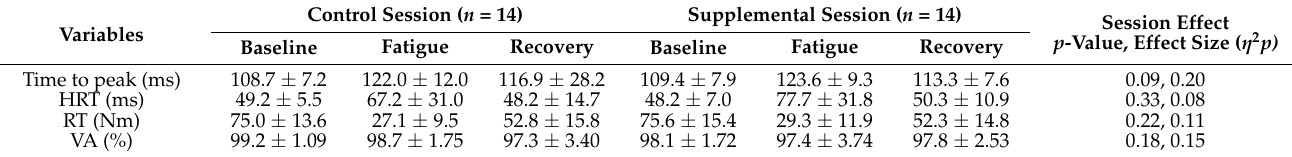
Table 2. Muscle contractile properties and voluntary